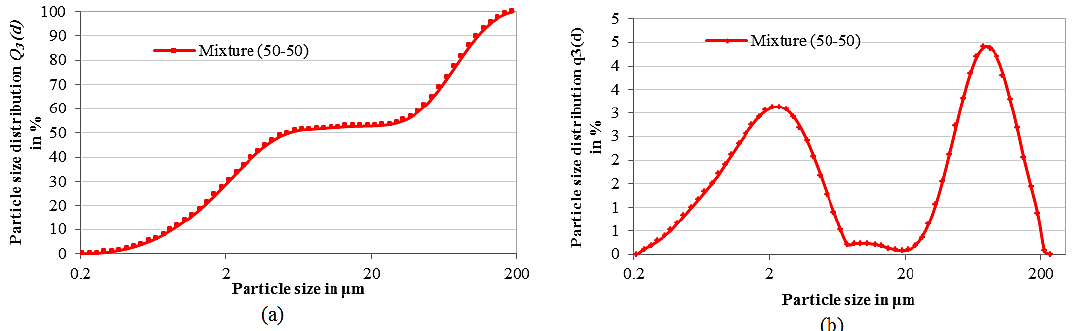
Figure 8. ( a ) Cumulative distribution function ( b ) Probability density function of the particle size for a binary mixture of 50% of ultra-fine + 50% of fine particles (laser Mastersizer 2000).